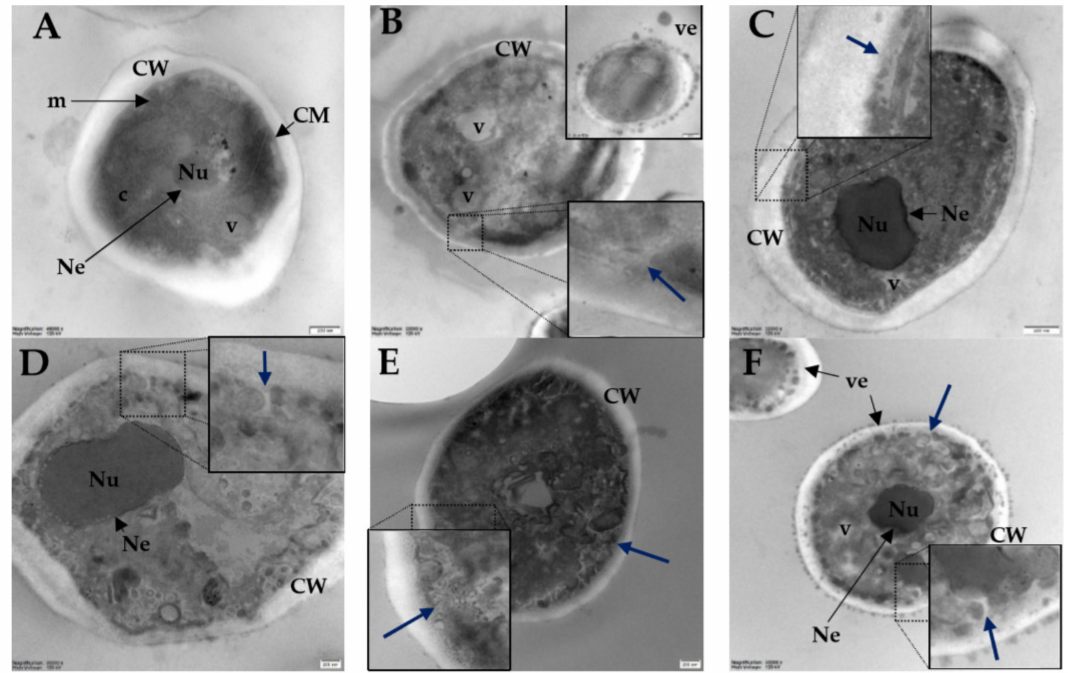
Figure 10. Transmission electron microscopy (TEM) images of C. albicans ATCC 10231 cells. ( A )—no additive, negative-control; ( B )—melittin as positive control; ( C )—lipopeptide L2 ; ( D )—lipopeptide C2 ; ( E )—lipopeptide L4 ; and ( F )—lipopeptide C4 . CM—cell membrane, CW—cell wall,